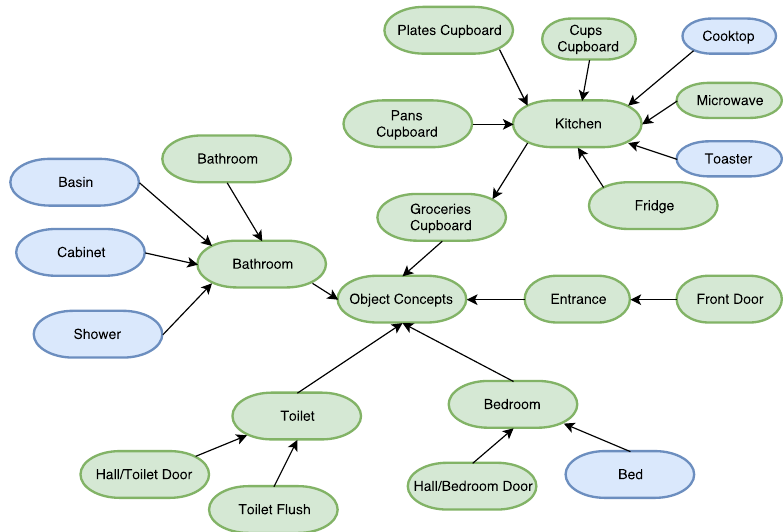
Figure 6. Common object concepts for Kasteren and Ordonez